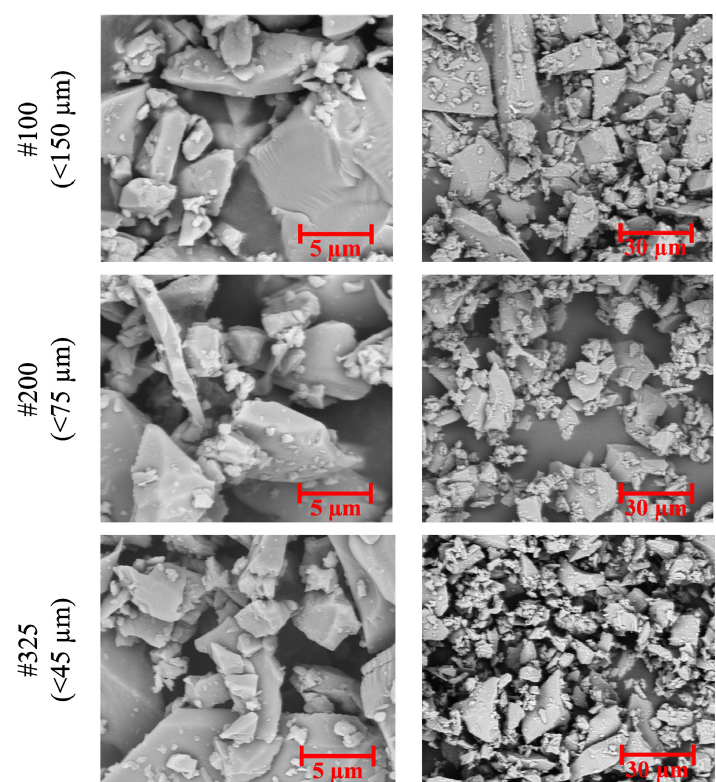
Figure 5. SEM Micrographs of glass powder of three grain sizes (<150 µm; <75 µm; <45 µm).